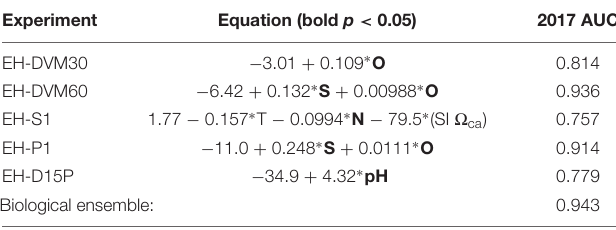
TABLE 5 | A biological ensemble of GLMs [significant predictors in bold ( p < 0.05)] assembled from models with strong in-sample performance (AUC (2009–2016) ≥ 0.64; see Table 4 for all models